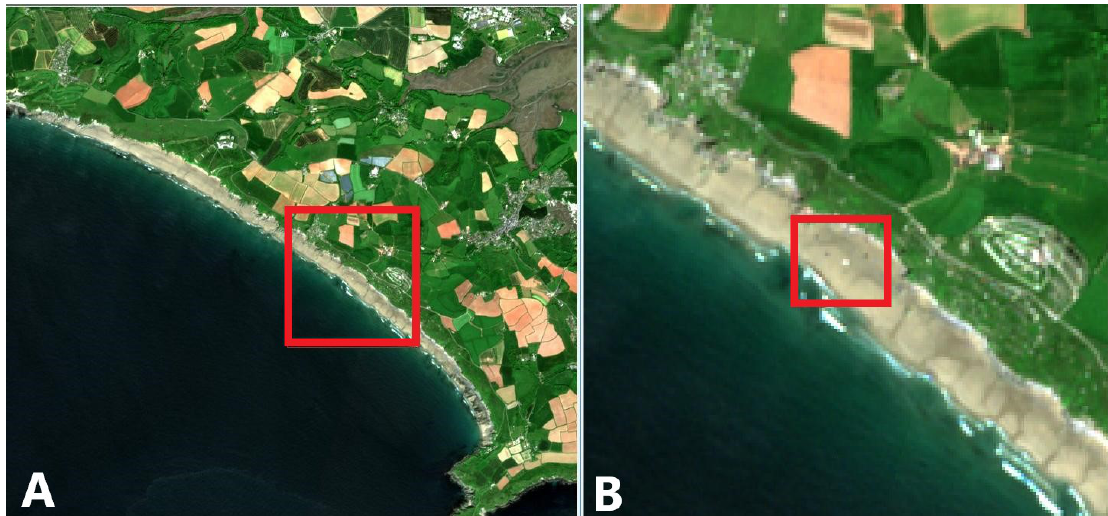
Figure 3. Example of plastic debris detection experiment during a Sentinel-2B overpass on 15 May 2018 over Whitsand Bay (United Kingdom). ( A ) Overview of the bay area with the study area indicated by a red square, shown in detail in ( B ) with the positions of the plastic targets (10 × 10 m) visible within the red